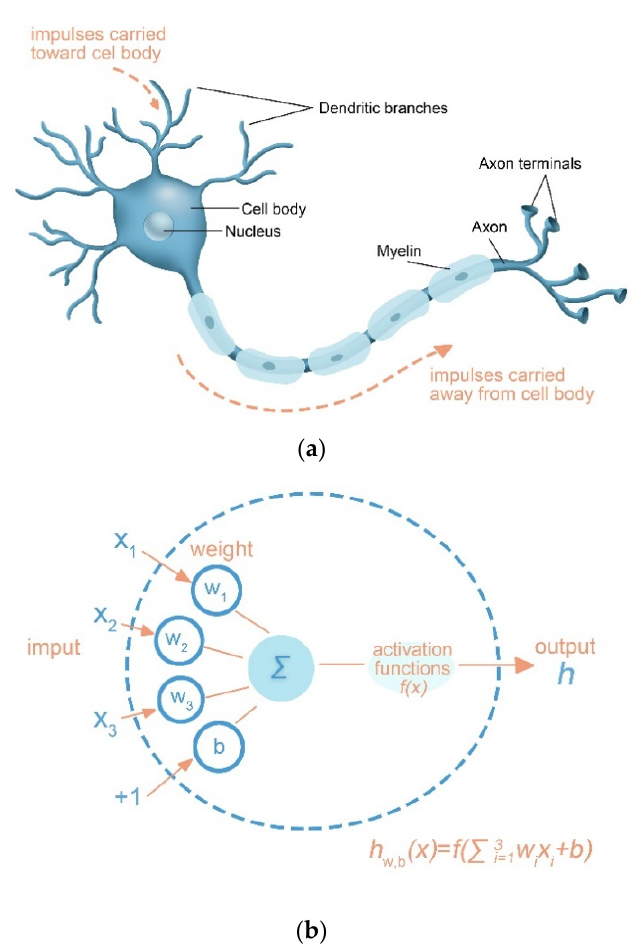
Figure 9. ( a ) Biological neuron model, ( b ) artificial neuron model.